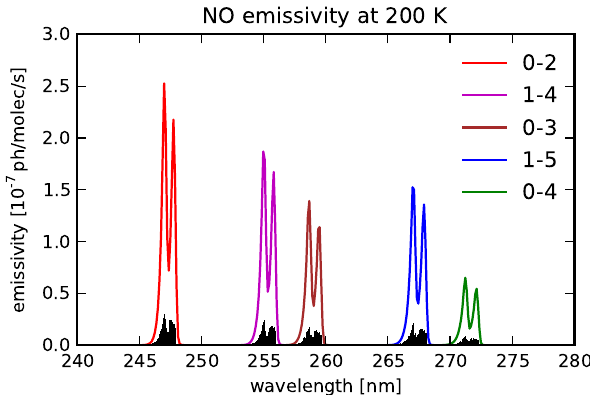
Fig. 1. NO emissivities calculated for a temperature of 200K for a selected number of gamma bands. The small black lines indicate the individual rotational emission lines within the vibrational transi- tion bands and the coloured lines are the emissivity bands resulting from binning to the SCIAMACHY spectral resolution and convolv- ing with the respective spectral slit